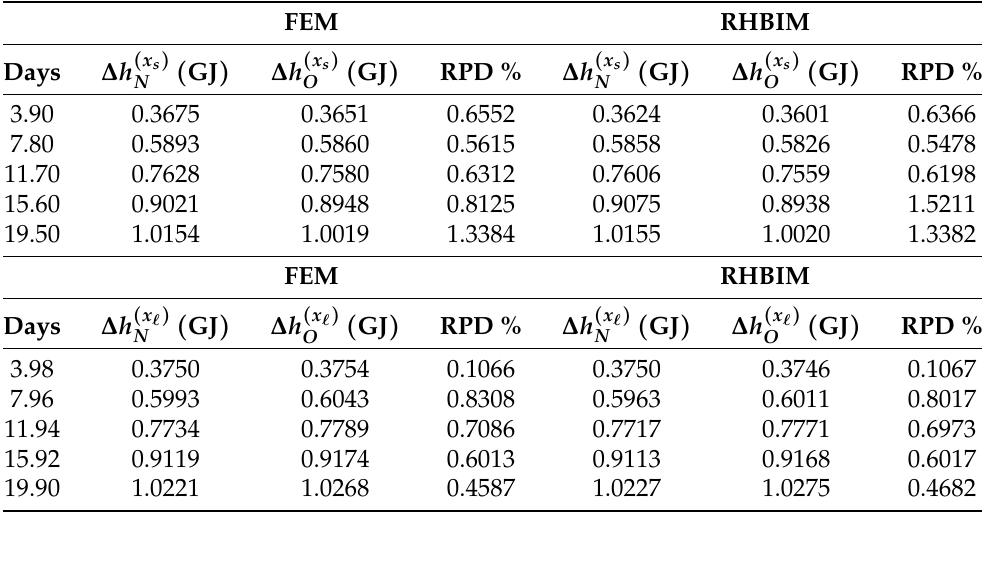
Table 4. Released energy ∆ h = h ( 0 ) − h ( t ) during solidification of KNO 3 according to the numerical and semi-analytical solutions to the new and old models. The RPDs are obtained from the example shown in Figure 3c,d.